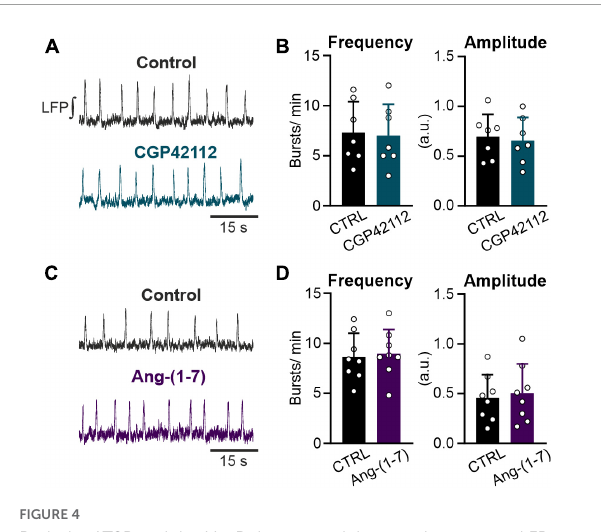
FIGURE4 Both the AT2R and the MasR do not modulate respiratory rate. LFP recordings in the preBötC in rhythmic acute brainstem slices. (A,C) Example traces of the integrated LFP for each condition. Control condition was recorded for 15 min followed by a 20 min treatment with (A,B) the AT2R agonist CGP42112 (500 nM) and (C,D) the MasR agonist Ang-(1–7) (10 nM). (B,D) Charts show the averaged data of 5 min intervals (CTRL 10–15 min and treatment 30–35 min). (B) N = 7 slices and (D) N = 8 slices. The data are presented as mean ± SD and were tested using a paired Student’s t